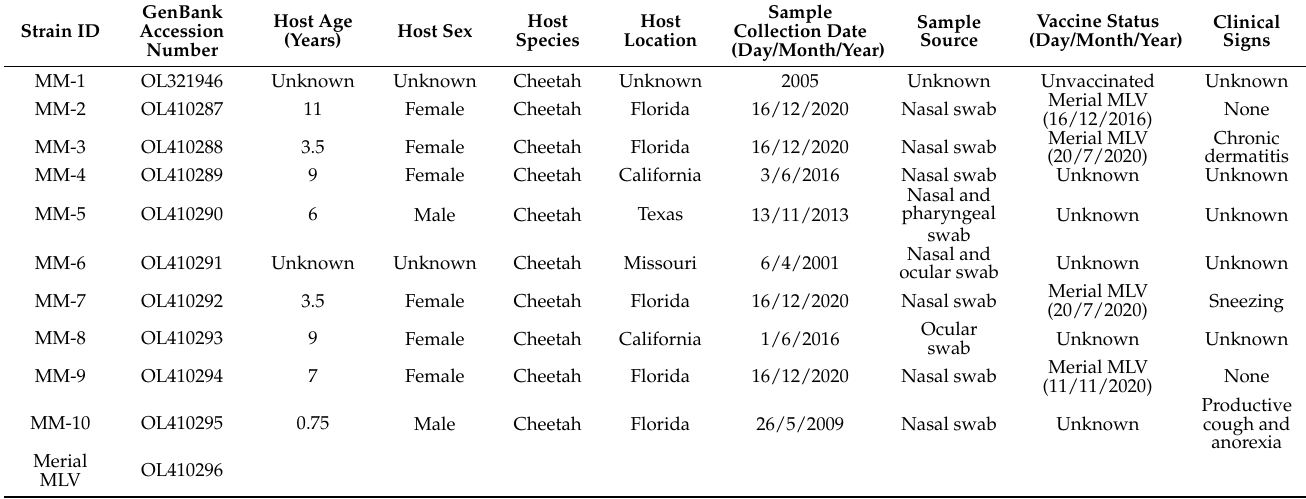
Table 1. Demographic and clinical data for feline herpesvirus type 1 (FHV-1) strains isolated from 10 captive cheetahs and the Merial Purevax Feline 3